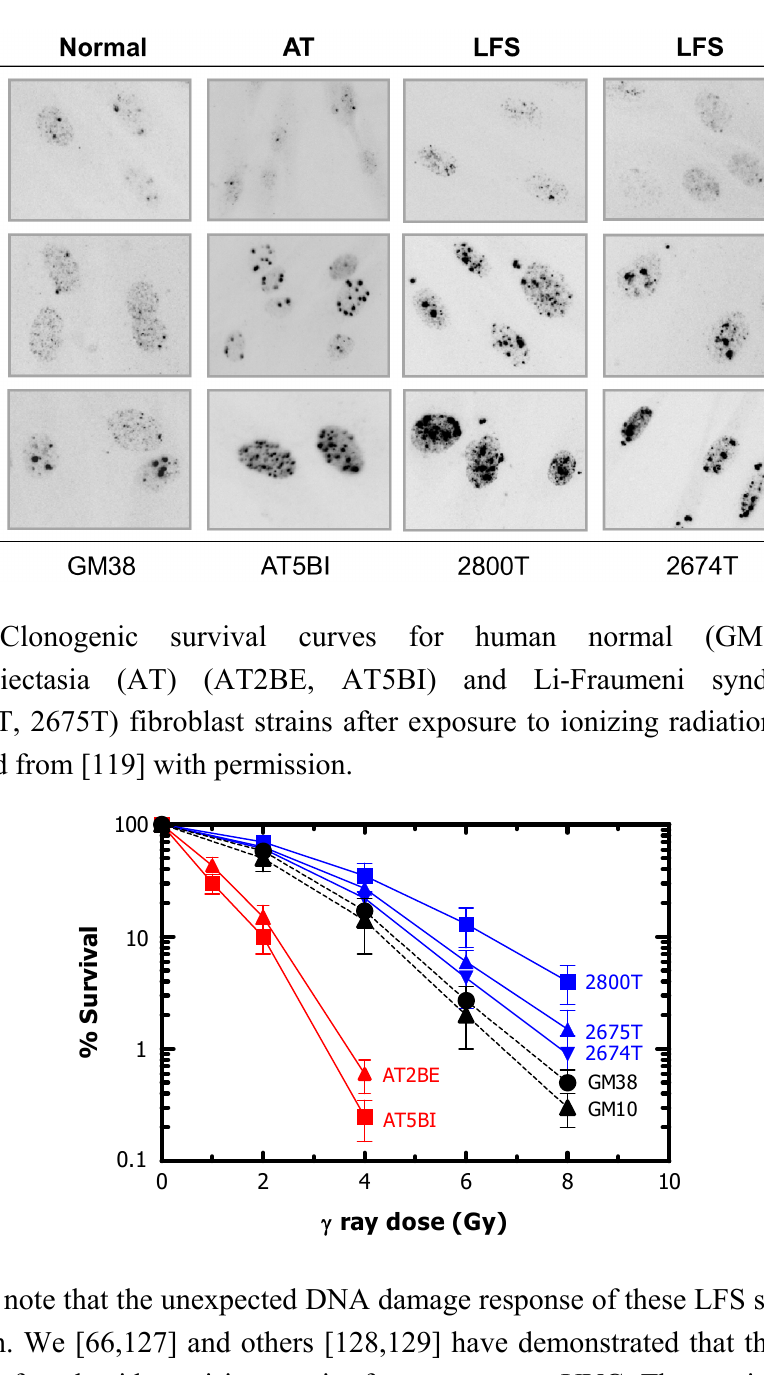
Figure 3. Immunofluorescence microscopy images showing γ H2AX nuclear foci before (control) and 48 h after exposure of the indicated human fibroblast strains to ionizing radiation. The results are reproduced from [119] with permission.